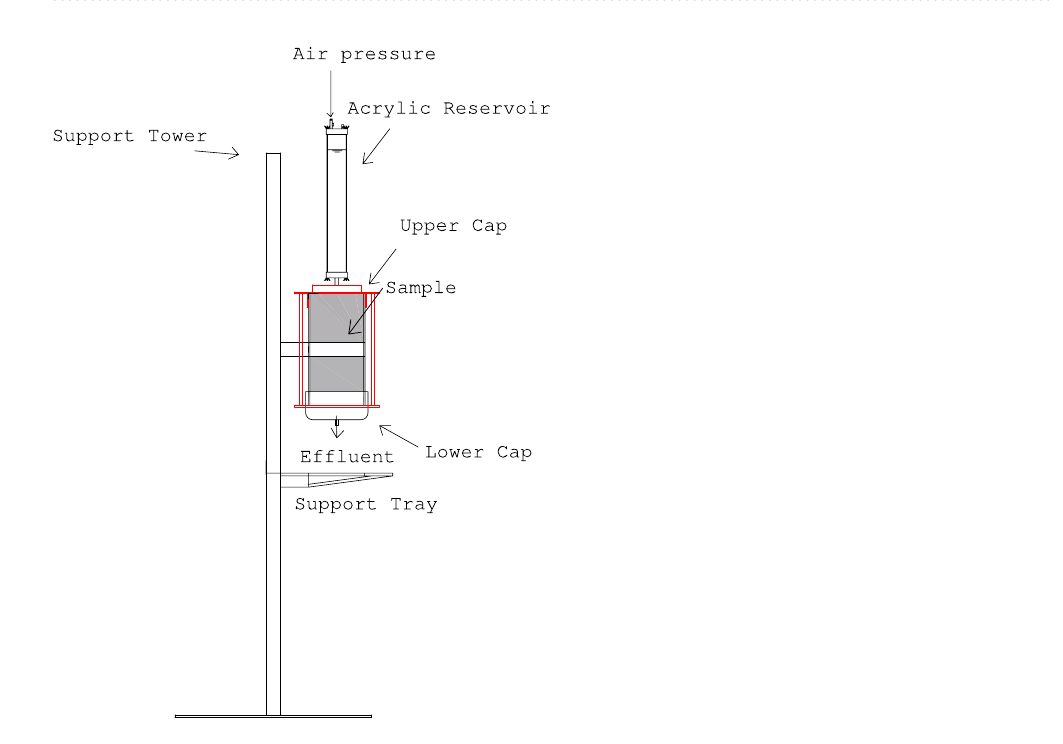
Table 2. PPW main properties. EC = electrical conductivity; T s = superficial tension; µ = viscosity; cP = centipoise. 1,2 ; samples from first and second sampling campaigns.